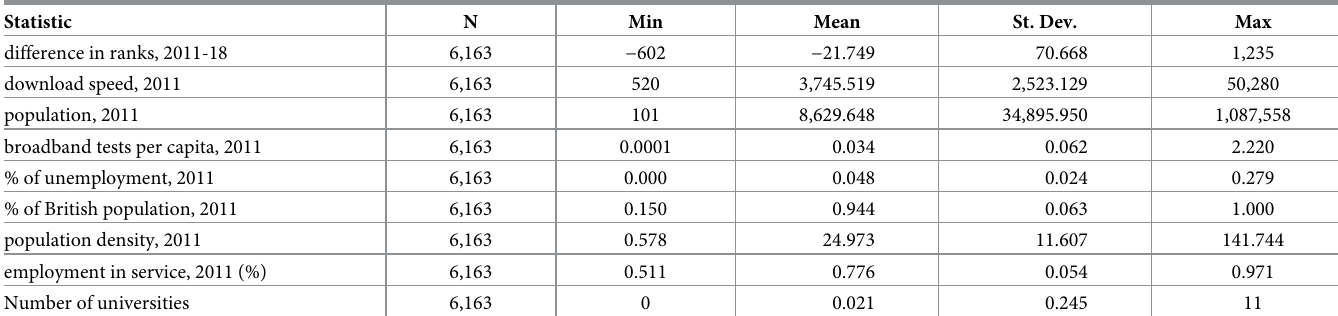
Table 9. Descriptive statistics for the UK